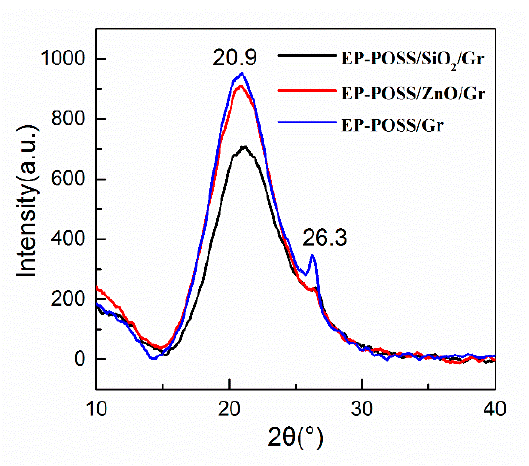
Figure 5. XRD spectra of EP-POSS film modified by nanoparticles.